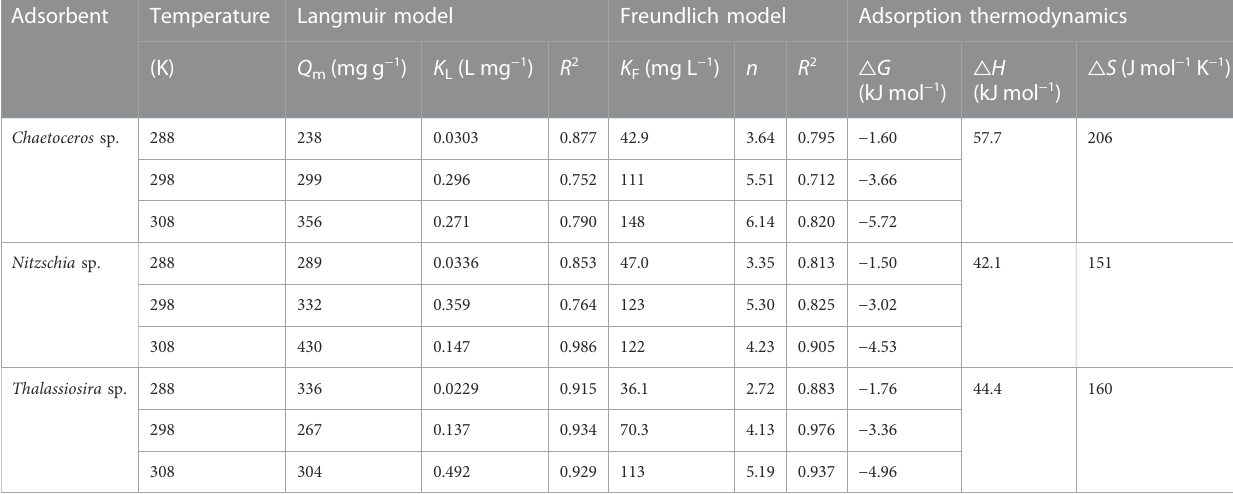
TABLE 2 Non-linear fi t parameters of Langmuir and Freundlich models and thermodynamic parameters for Cd(II) adsorption onto various non-living marine diatom biomass.